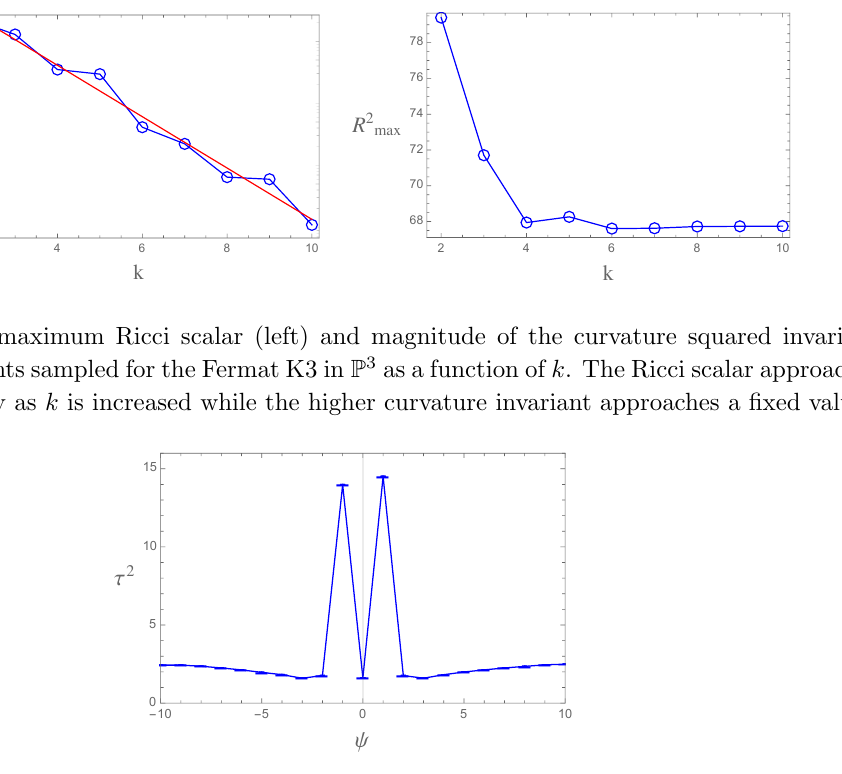
Figure 3 . The dimensionless measure of the maximum value of second order curvature invariants on the sampled points, (cid:28) 2 from (3.1), as a function of for the one parameter family of quartics in P 3 (3.2). The expected features in this plot, given the known location in moduli space of curvature singularities, are correctly